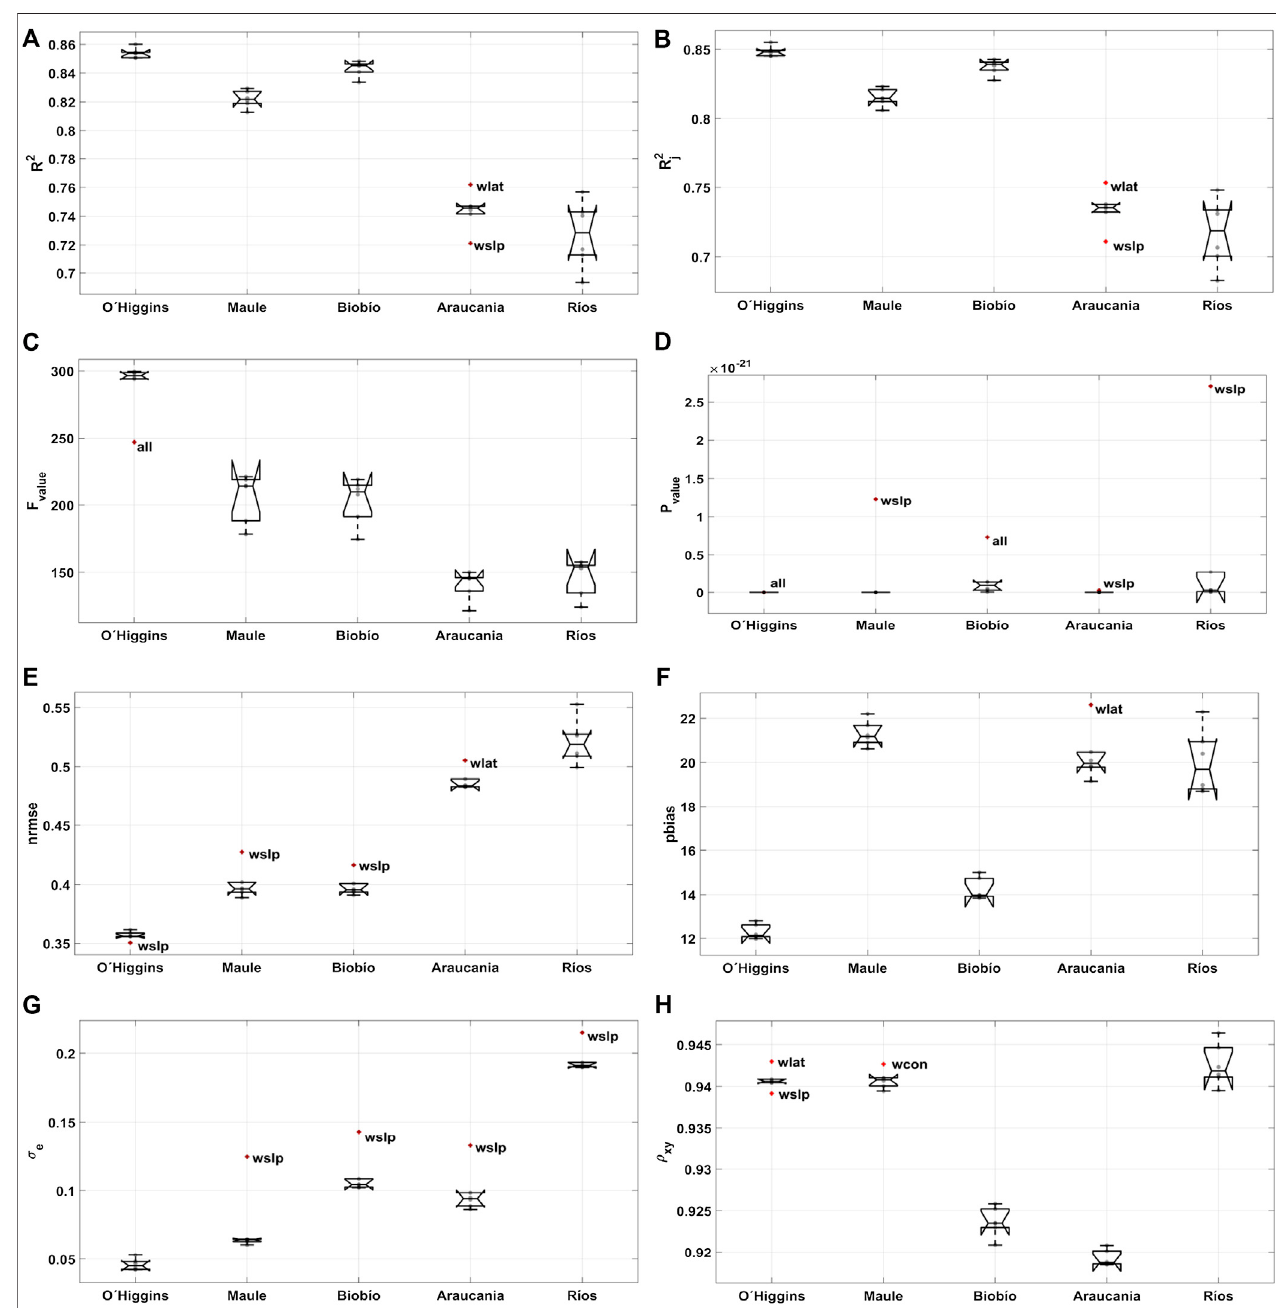
FIGURE 10 | Box diagrams corresponding to the adjustment of the topo-climatic model on the domains in execution. (A) Multiple determination coef fi cient ( R 2 ) , (B) adjusted multiple determination coef fi cient R